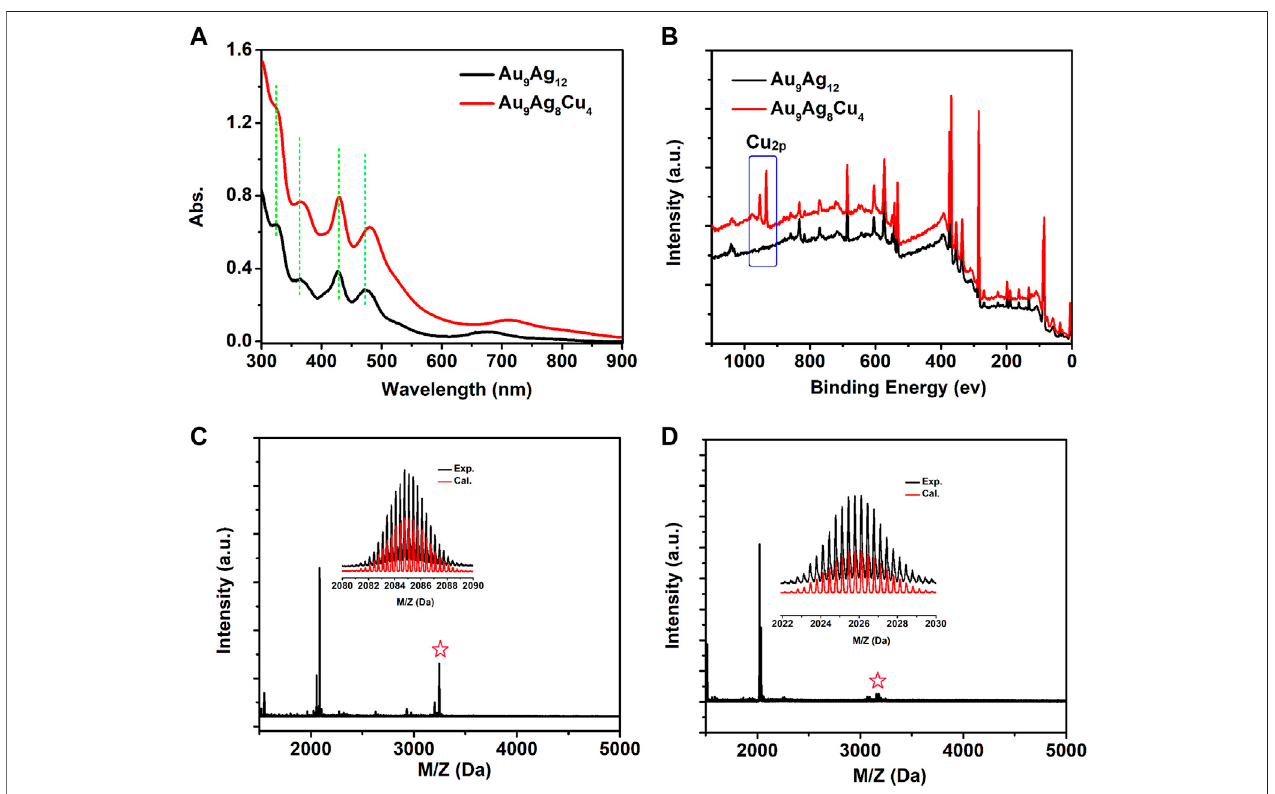
FIGURE 1 | (A) Optical absorption spectra and (B) the XPS spectra of [Au 9 Ag 12 (SAdm) 4 (Dppm) 6 Cl 6 ](SbF 6 ) 3 (black line) and [Au 9 Ag 8 Cu 4 (SAdm) 4 (Dppm) 6 Cl 6 ](SbF 6 ) 3 (red line); ESI-MS spectra of (C) [Au 9 Ag 12 (SAdm) 4 (Dppm) 6 Cl 6 ](SbF 6 ) 3 and (D) [Au 9 Ag 8 Cu 4 (SAdm) 4 (Dppm) 6 Cl 6 ](SbF 6 ) 3. The peaks labeled by asterisks in Panels (C, D) correspond to [Au 9 Ag 12 (SAdm) 4 (Dppm) 6 Cl 6 +(SbF 6 )] 2+ and [Au 9 Ag 8 Cu 4 (SAdm) 4 (Dppm) 6 Cl 6 +SbF 6 ) 2+ , respectively.